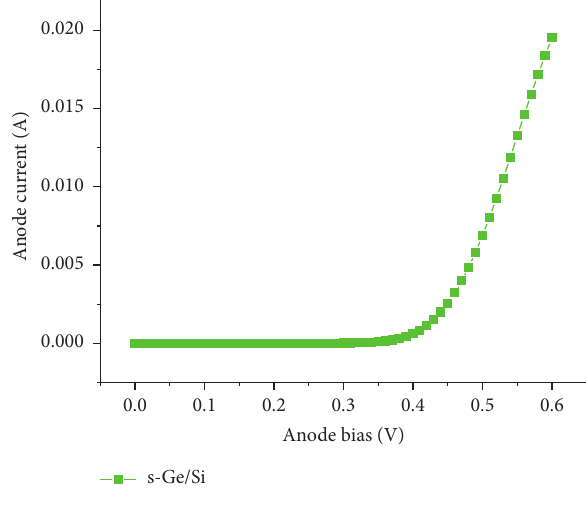
Figure 7: s-Ge/Si Schottky diode I-V